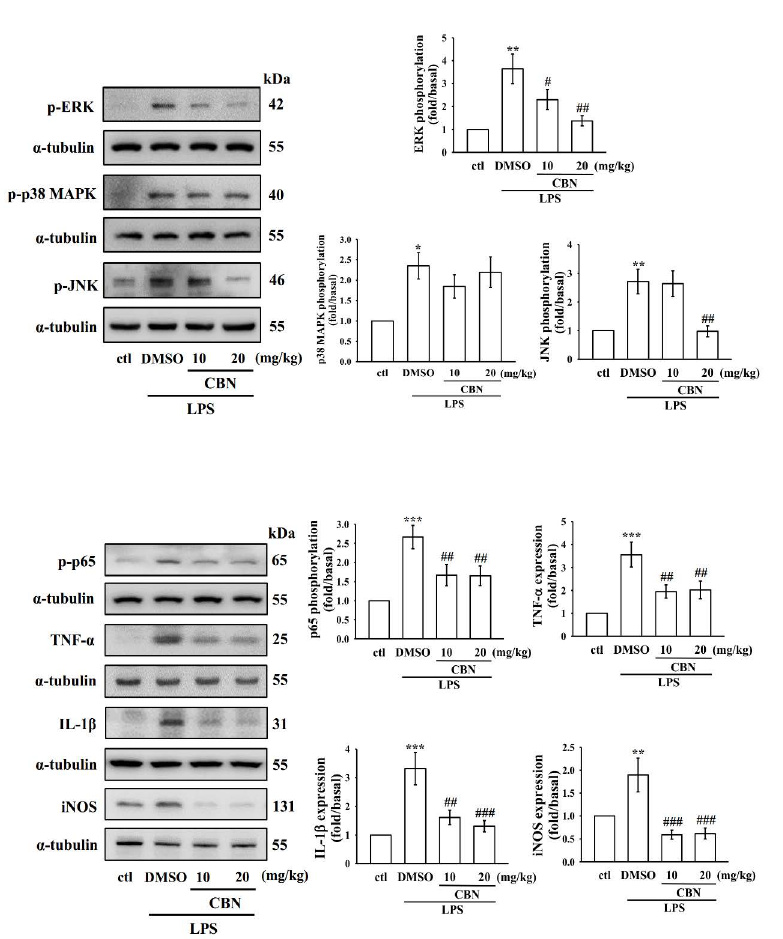
Figure 6. Effects of CBN on the expression of MAPK/NF- κ B p65, TNF- α , and IL-1 β and iNOS in LPS-induced liver tissue. Mice were treated with CBN (10 and 20 mg/kg) for 2 h and then induced by LPS (1 µ g/mL) for 6 h. The expression of phosphorylated ERK, p38, JNK, and p65 and the protein expression of TNF- α , IL-1 β , and iNOS were evaluated as described in the Materials and Methods. Data presented are the means ± S.E.M. ( n = 6); * p < 0.05, ** p < 0.01, and *** p < 0.001, LPS vs. control group; # p < 0.05, ## p < 0.01, and ### p < 0.001, LPS vs. CBN group. The statistical power range was from